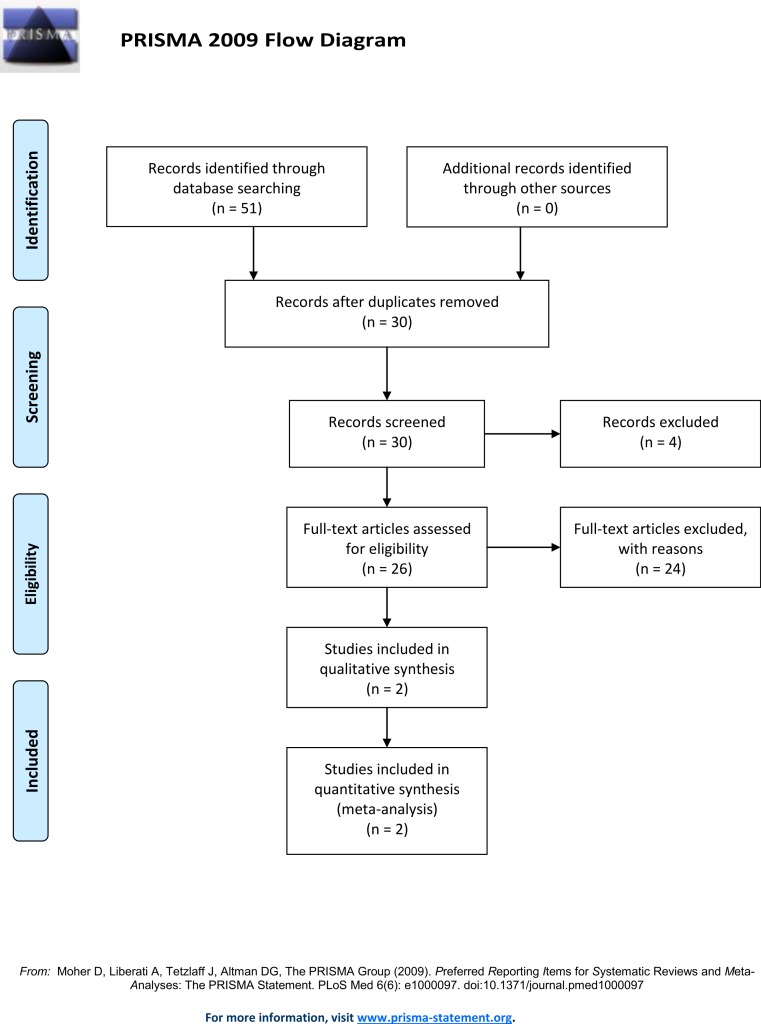
Prisma flow diagram.